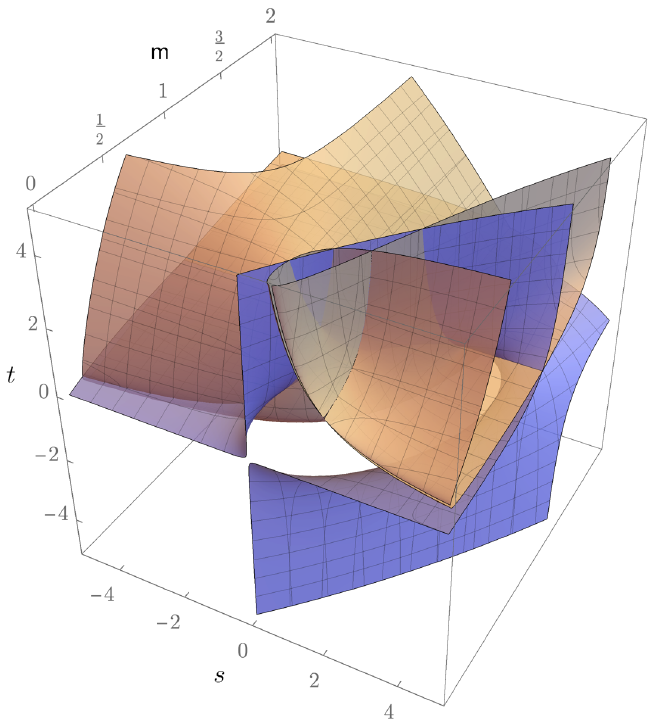
( E ) for the double-box diagram given in dbox